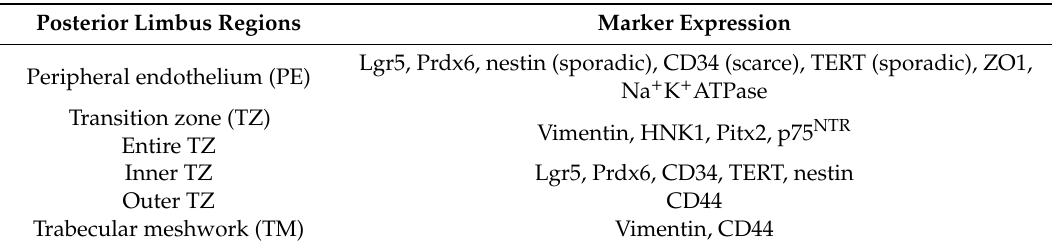
Table 1. Site-specific expression of stem / progenitor and corneal endothelial di ff erentiation markers.